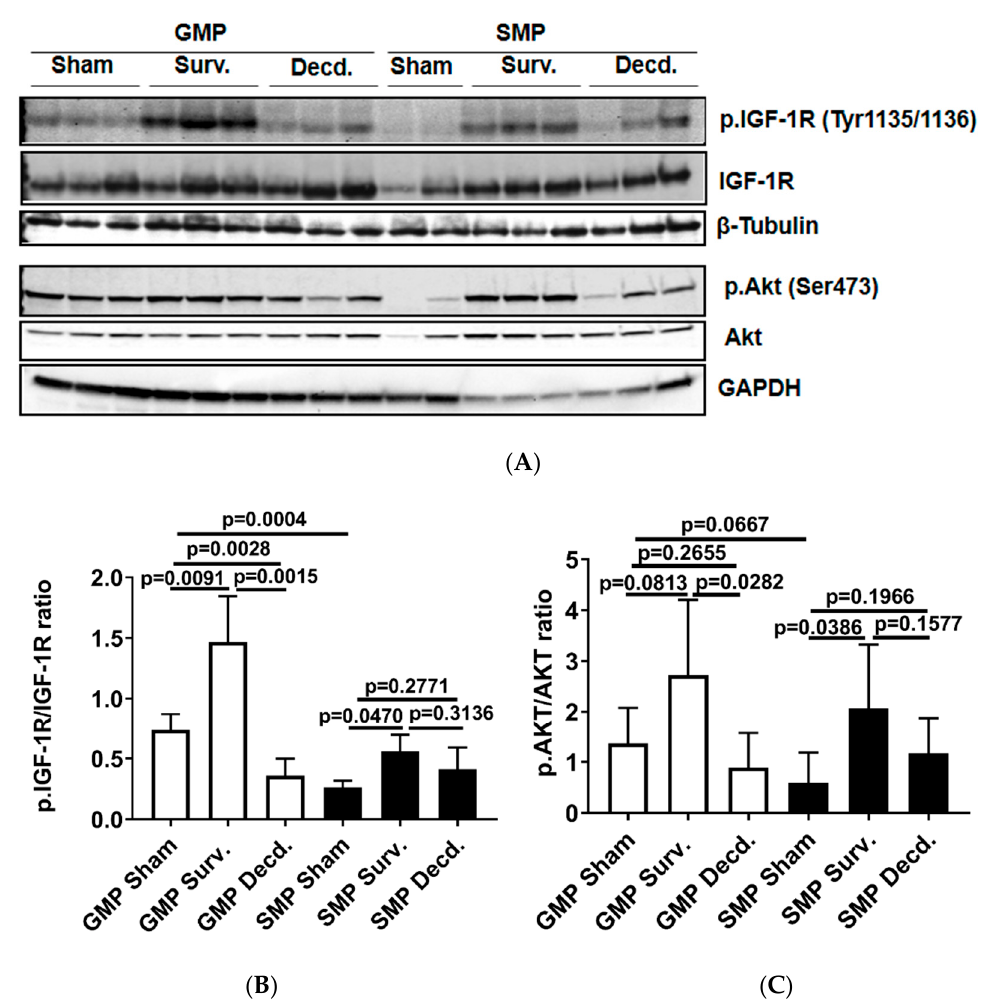
Figure 2. Cardiac IGF-1 receptor (IGF-1R) is differentially regulated in Gottingen minipig (GMP)/SMP strains and is significantly impacted by irradiation. ( A ) Western blot analysis of phosphorylated IGF-1R and Akt in heart protein lysates of non-irradiated control and irradiated survivor (Surv.) or decedent (Decd.) GMP and SMP. Glyceraldehyde 3-phosphate dehydrogenase (GAPDH) and β -Tubulin blots are included as loading controls. (B – C ) Graphs representing the analysis of IGF-1R and Akt phosphorylation in the protein lysates of control and irradiated animals by western blot.